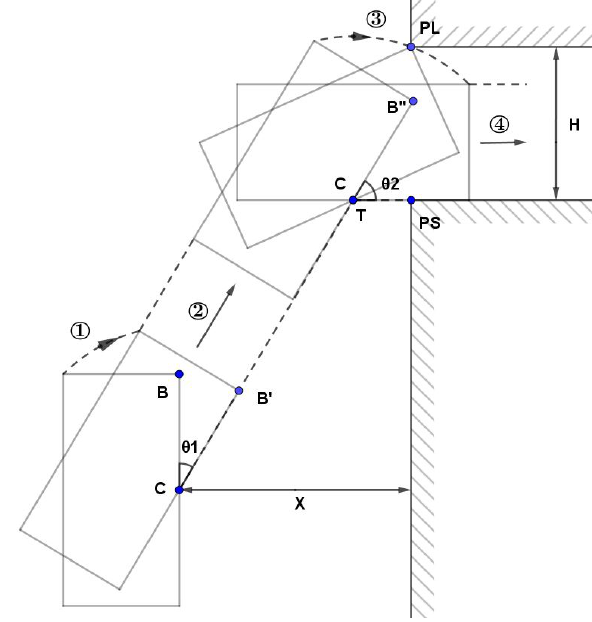
Figure 12. overall path of RRB entering the